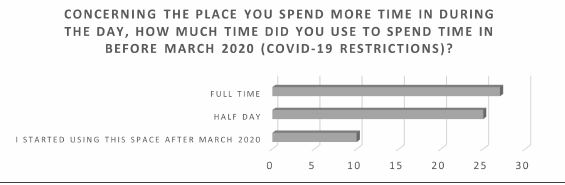
Figure 9: Time subjects used to spend in the most frequented place in the period before COVID-19 restrictions.